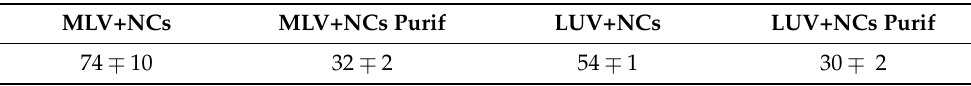
Figure 8. Normalized emission intensity spectra of the vesicles encapsulating the NCs: ( a ) MLVs and ( b ) LUVs before and after elimination of free NCs. Table 1. Gold concentration [ Au ] in the suspension of vesicles encapsulating C 3 E 6 D Red mg · L − 1 NCs before and after purification determined by ICP mass spectroscopy.